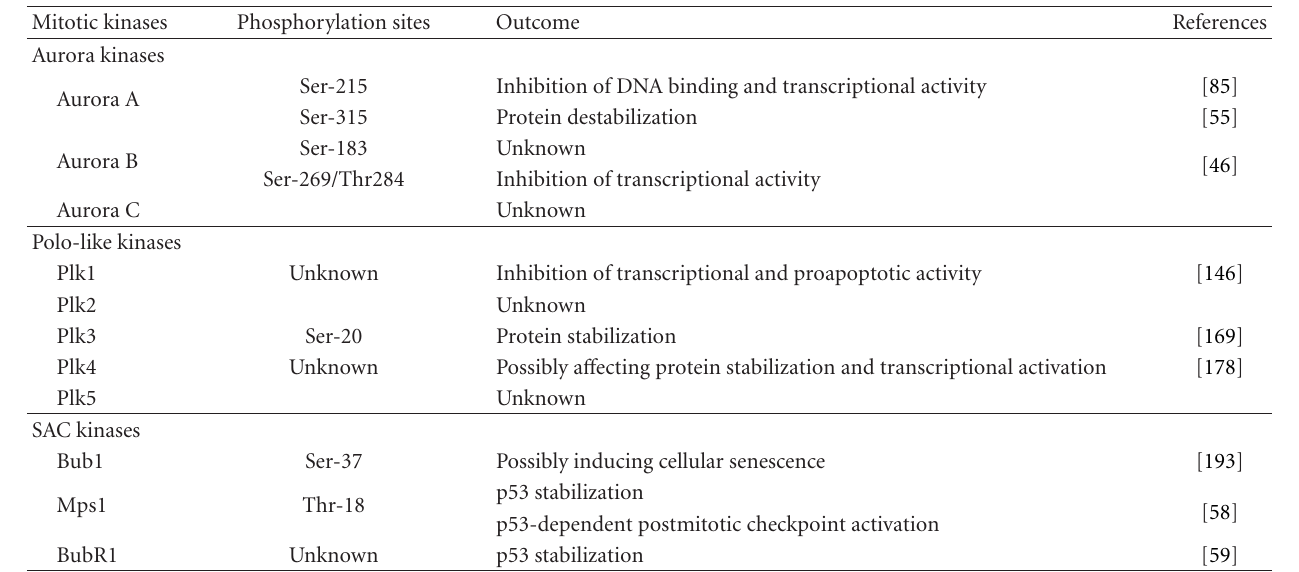
Table 1: Mitotic kinases-mediated p53 phosphorylation and the possible